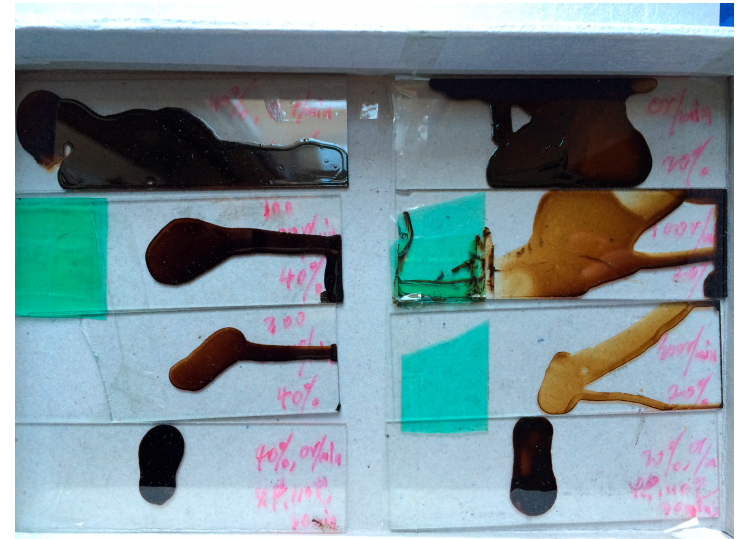
Figure 1. Preparation of bitumen samples.